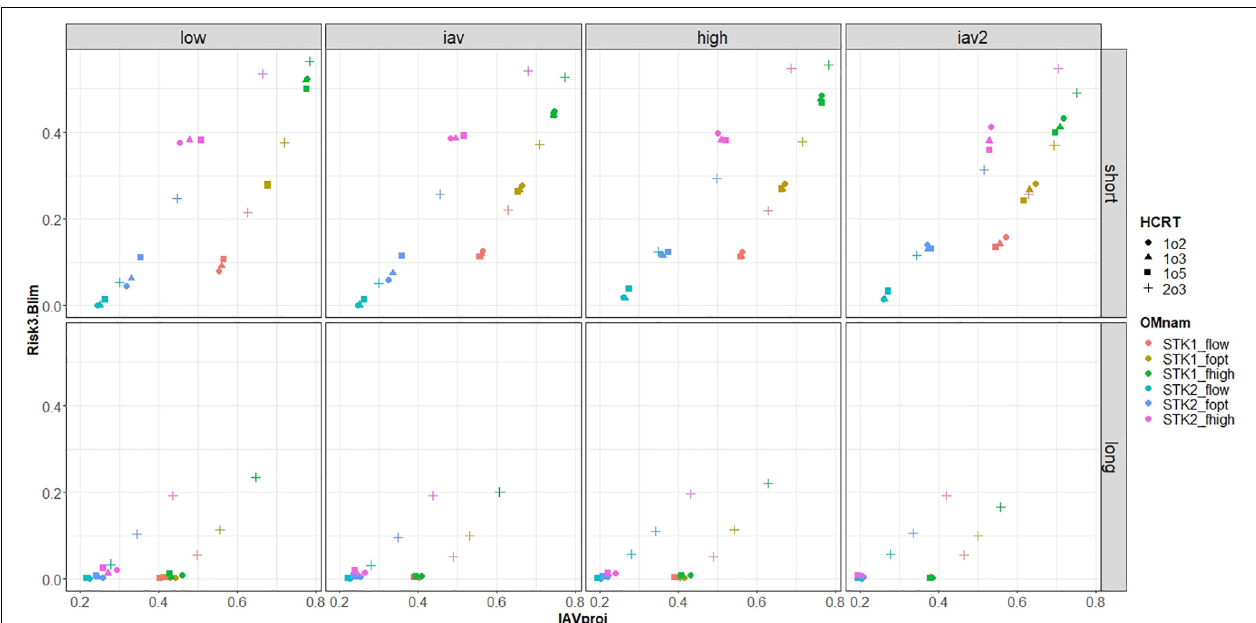
FIGURE 11 | Biological risks (Risk3.Blim: maximum probability of falling below B lim ) versus the interannual variability (x-axis) under an in-year advice. The columns correspond to the CVs of the index and the rows to the timeframes: the short-term (first 5 projection years) and the long-term (last 10 projection years). The harvest control rule types without any uncertainty cap are represented by the dot types and the operating models (combination of stock-type and historical exploitation level) are represented by the dot colours. See Table 1 for definitions of abbreviations. Interactive version of the figure is available online at